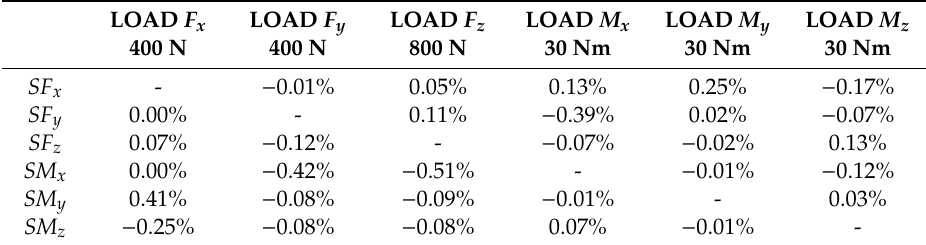
Figure 12. Comparison of numerical and analytical solutions under F x / F y , F z , M x / M y , and M z of the optimized elastic beams. Table 6. Cross-talk readings of the FEA results of the optimized sensor.